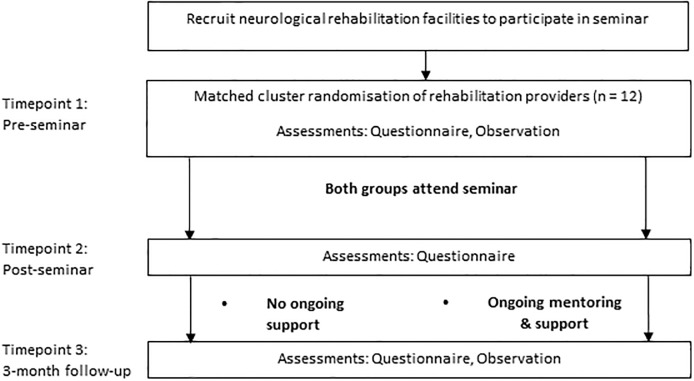
Study flow diagram.